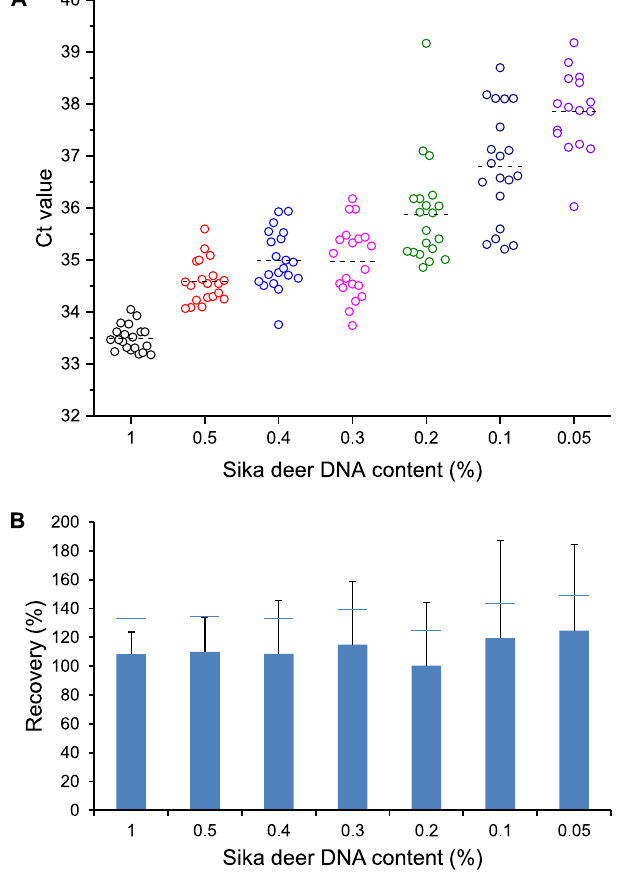
Figure 3. Determination of LOD and LOQ by analysing serial dilutions of a DNA mixture containing 1% (w/w) sika deer and 99% (w/w) pig DNA (non-target DNA). Measurements were carried out in 20 replicates. ( A ) Dot density plot. Circles represent individual Ct values. The horizontal lines indicate the mean values. ( B ) Column plot showing mean recovery and relative standard deviation (RSD). Horizontal lines indicate a RSD of